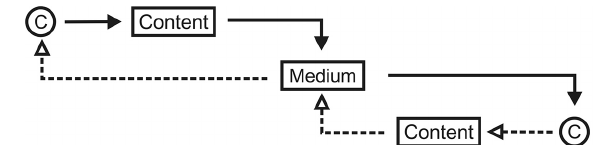
Figure 2. Model of interpersonal computer-mediated communication (source: Hoffman & Novak,